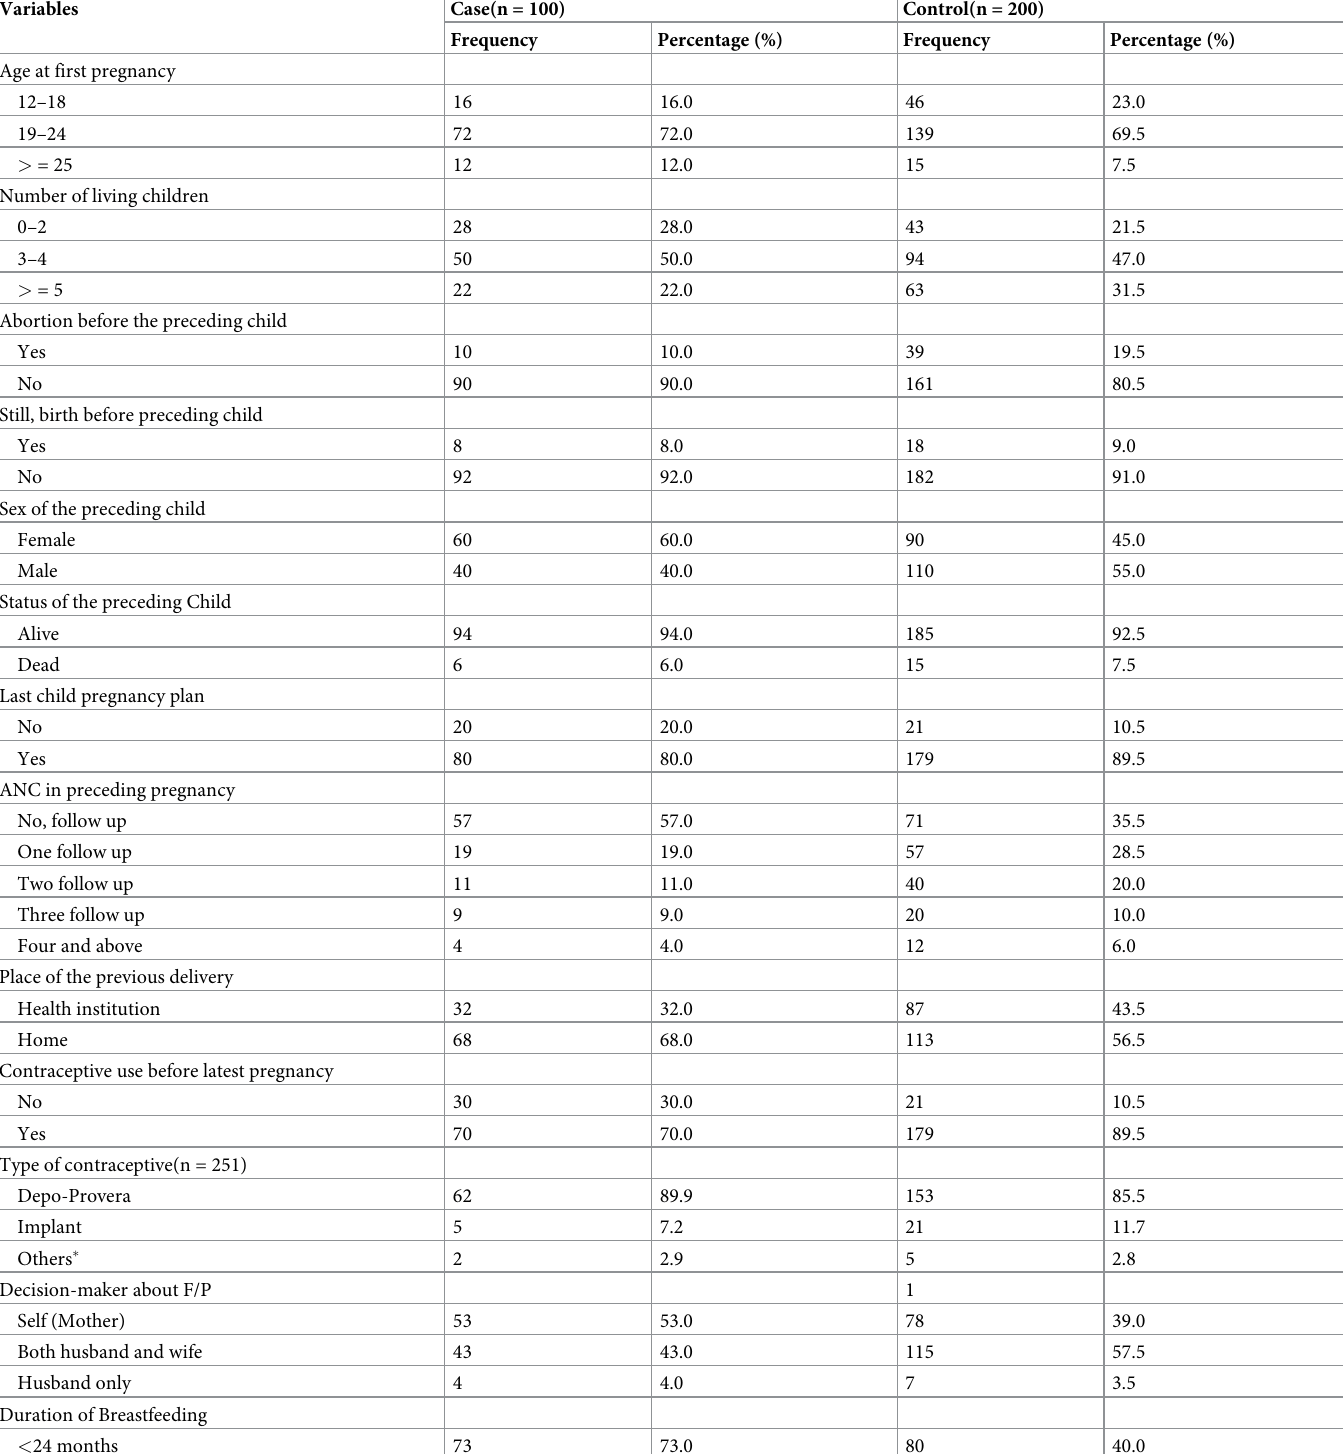
Table 2. Obstetric, breastfeeding, and contraception history of reproductive age mothers (N = 300) in Farta Woreda, South Gondar Zone, North West, Ethiopia,